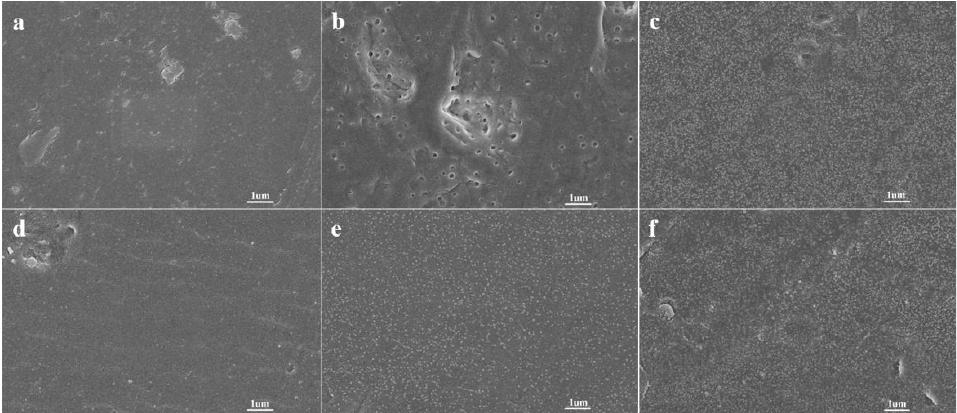
Figure 2. SEM images of the surface of FEP films activated by sodium naphthalene-DMI solution with different concentrations and activation times: ( a ) FEP-DMI-0.7 M-5 min, ( b ) FEP-DMI-0.7 M-15 min, ( c ) FEP-DMI-0.7 M-30 min, ( d ) FEP-DMI-0.9 M-5 min, ( e ) FEP-DMI-0.9 M-15 min, ( f ) FEP-DMI-0.9 M-30 min.